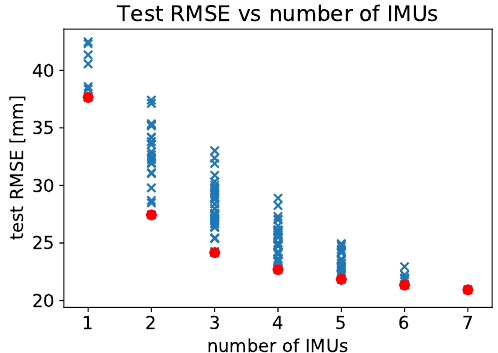
Figure 9. Dependence of the test error on the number of IMUs used. All subjects, linear model. Each point represents a placement configuration of IMUs. Possible locations for IMUs are shown in Figure